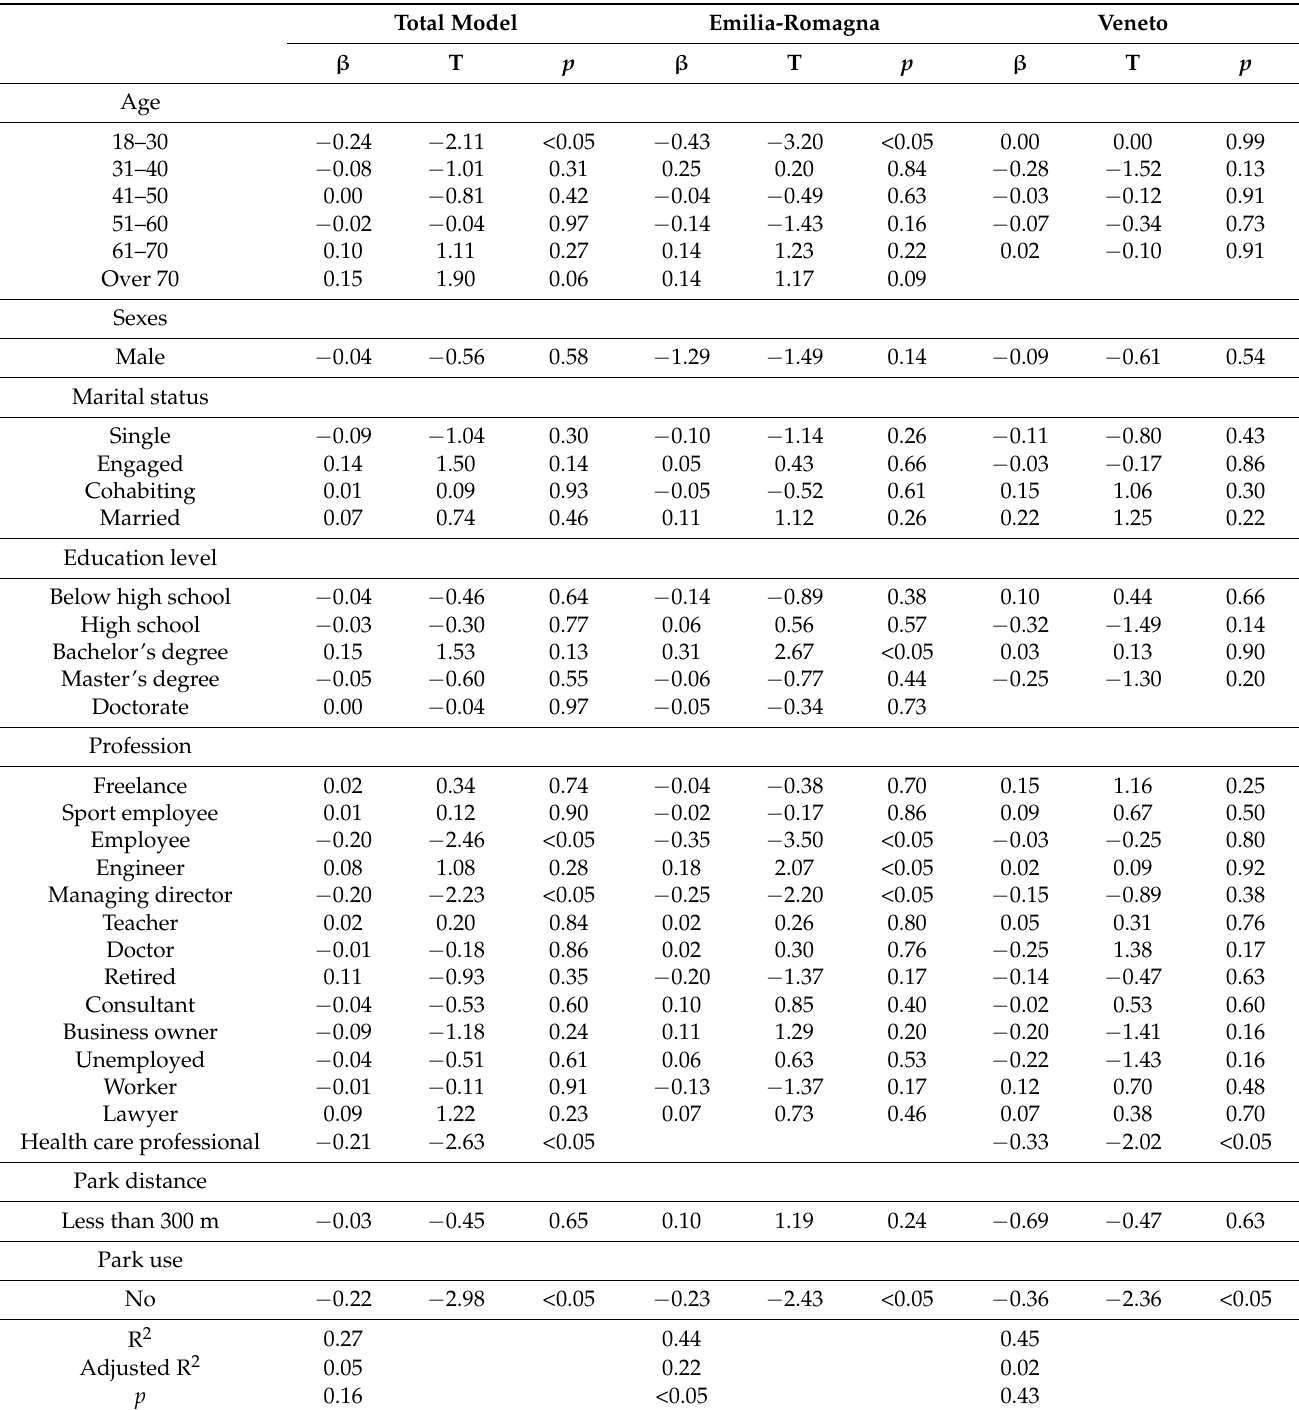
Table 6. Multiple regression model for the cognitive